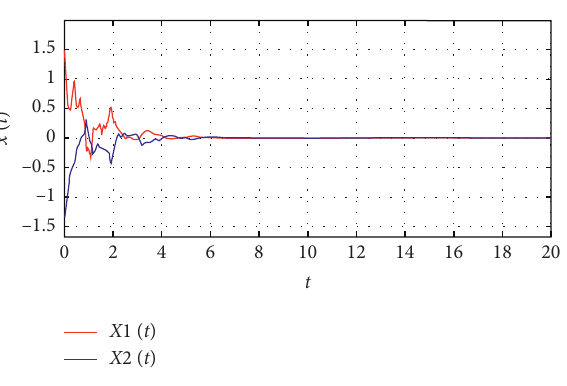
Figure 2: State 2 response